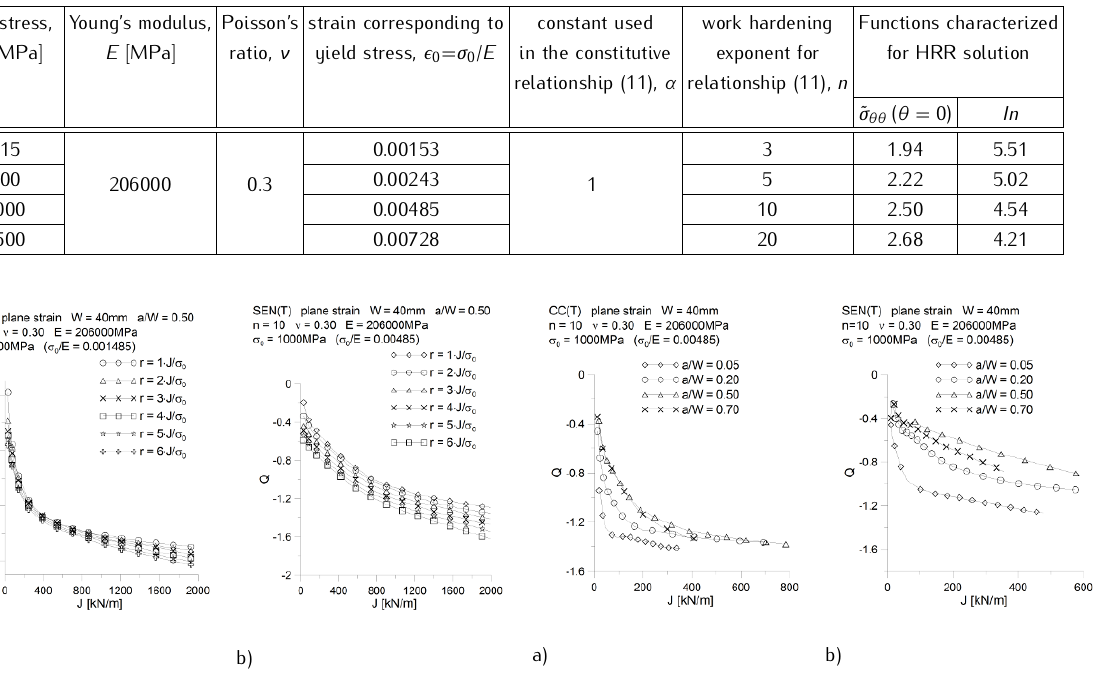
Figure 8. The influence of the relative crack length for CC(T) and SEN(T) specimens for n =10, σ 0 =1000 MPa (plane strain for distance from crack tip r =2.0 · J / σ 0